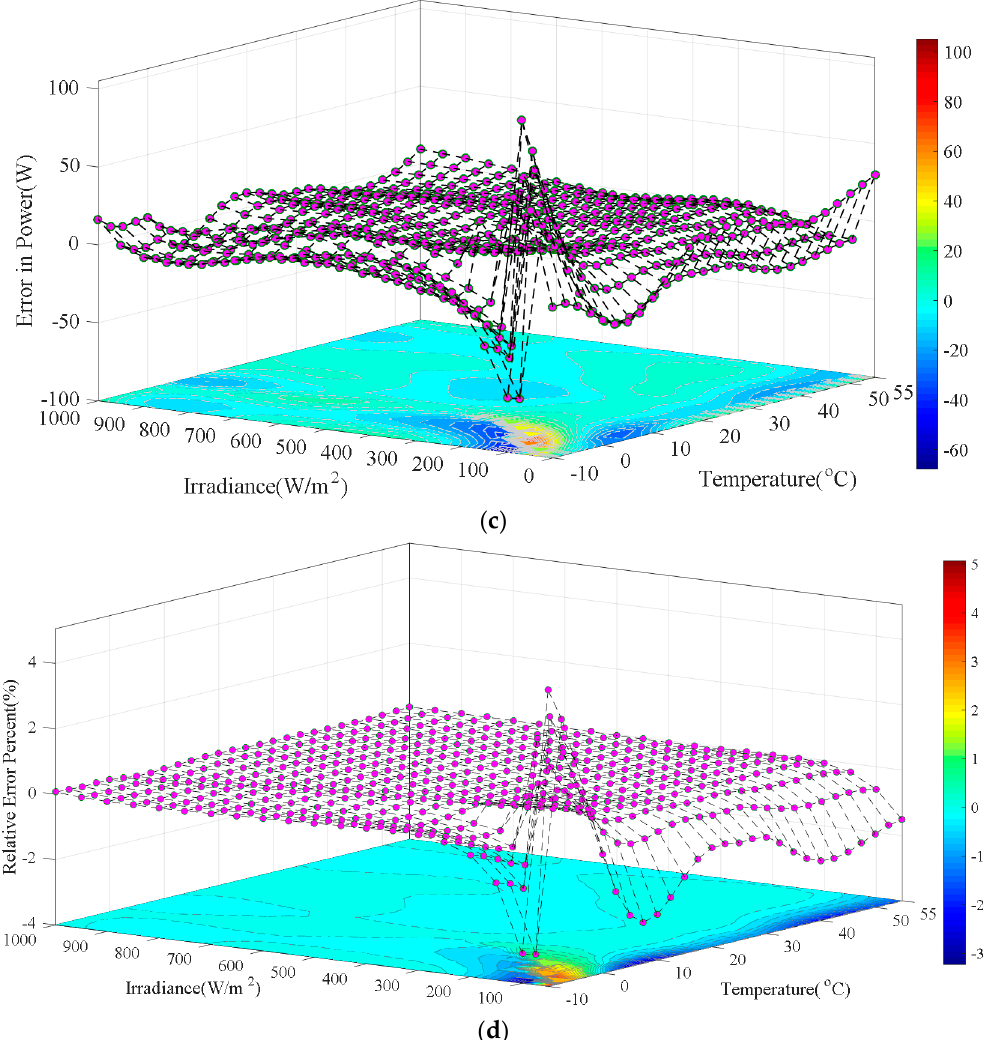
Figure 6. Testing data for ANN controller: ( a ) Output of the neural-network training with the amount of target data; ( b ) Mean-squared-error (MSE) in converging process; ( c ) Absolute error in neural-network training; ( d ) Relative error in neural-network training.